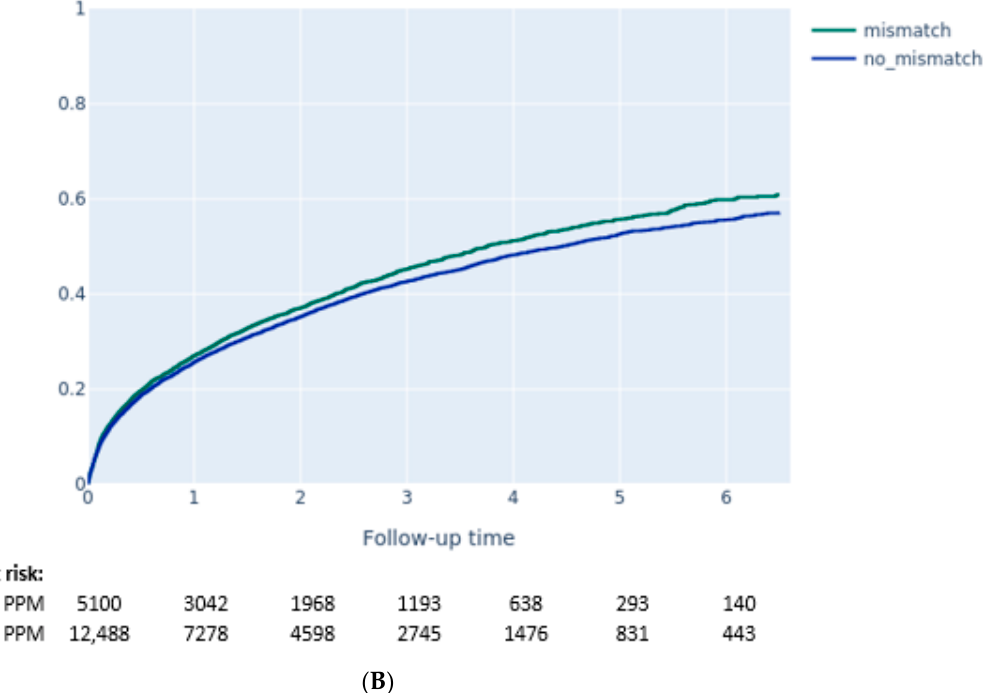
Figure 3. ( A ) Cumulative incidence of occurrence of first hospitalization for heart failure according to the presence of moderate-to-severe patient–prosthesis mismatch (Kalbfleisch and Prentice curve). ( B ) Cumulative incidence of occurrence of arrhythmia according to the presence of moderate-to-severe patient–prosthesis mismatch (Kalbfleisch and Prentice curve).